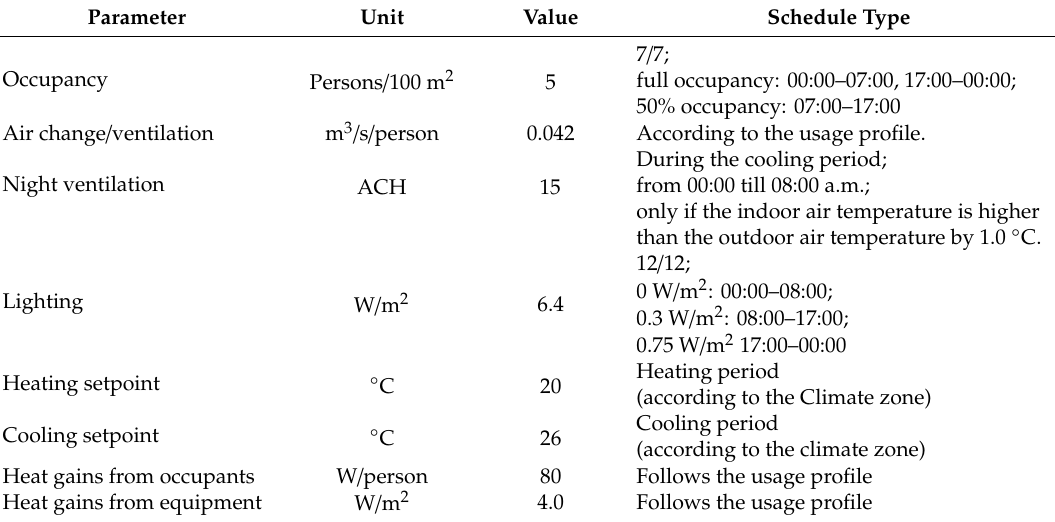
Table 3. Boundary conditions and operational schedules, considered for the